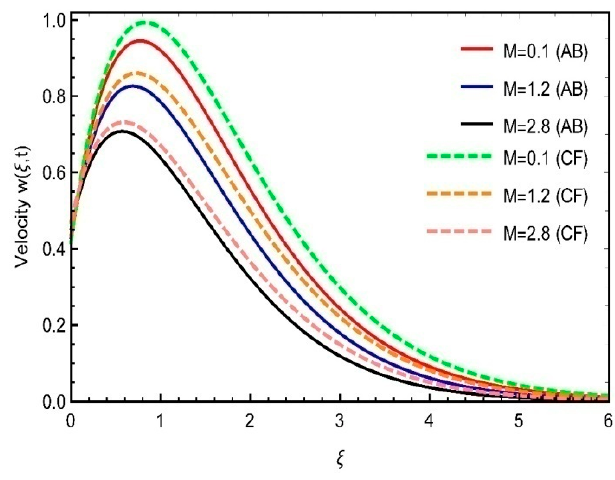
Figure 6. Change in velocity for 𝑀.